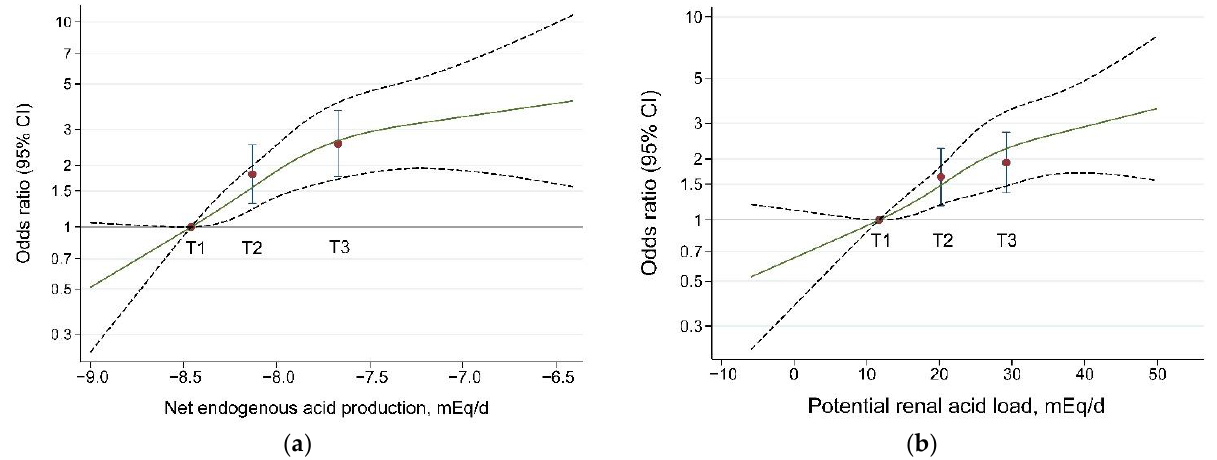
Figure 1. Dose–response associations of the levels of dietary acid load with the risk of hip fracture using restricted cubic spline analyses. ( a ) Net endogenous acid production and hip fracture. ( b ) Po- tential renal acid load and hip fracture. Restricted cubic splines (RCS) with four knots were used to estimate the associations in conditional regression models. Models were adjusted for potential confounders (see Model 3 in Table 2). The reference value was median level of tertile 1. The solid lines and the red circles refer to estimates of odds ratios (OR); the dashed lines and the error bars represent 95% CI. T1, T2, and T3: tertiles 1 to 3.